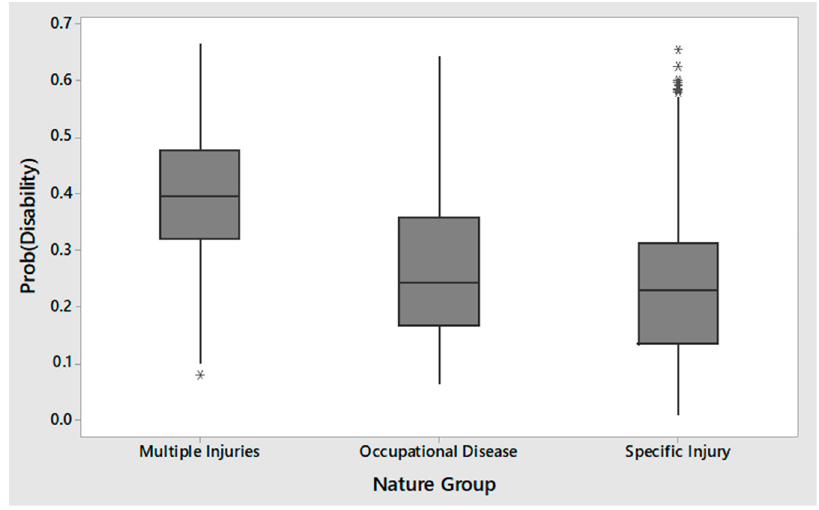
Figure 3. Boxplot of disability post-incident state for each nature of injury group. (* shows the outlier data points).